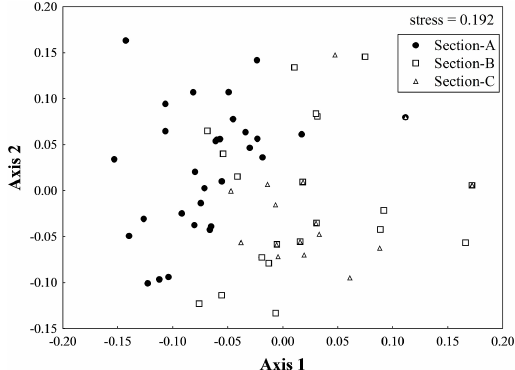
Figure 5. Non-metric Multidimensional Scaling (NMDS) showing differences in plot composition along the depth gradient (sections A, B and